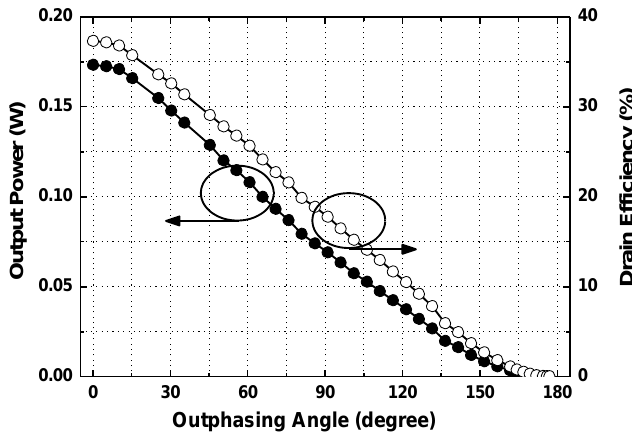
Figure 13. Block diagram for measurement of the outphasing PA.